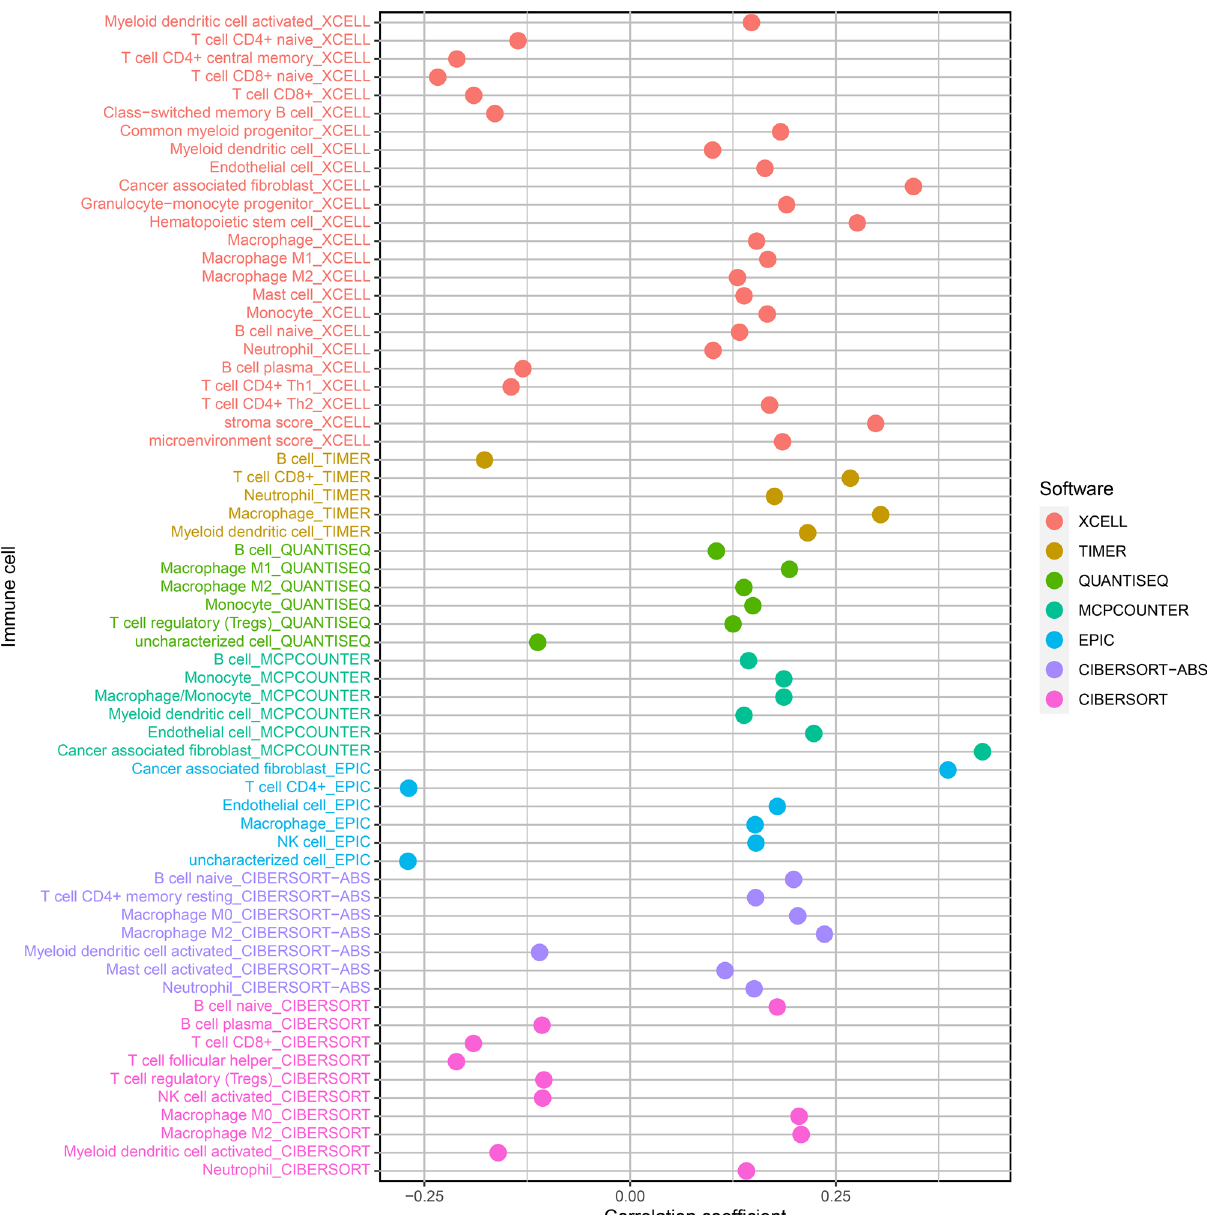
Figure 6. Correlations between risk score and immune cell infiltrations of bladder cancer specimens by following software: XCELL; TIMER; QUANTISEQ; MCPCOUNTER; EPIC; CIBERSORT-ABS and